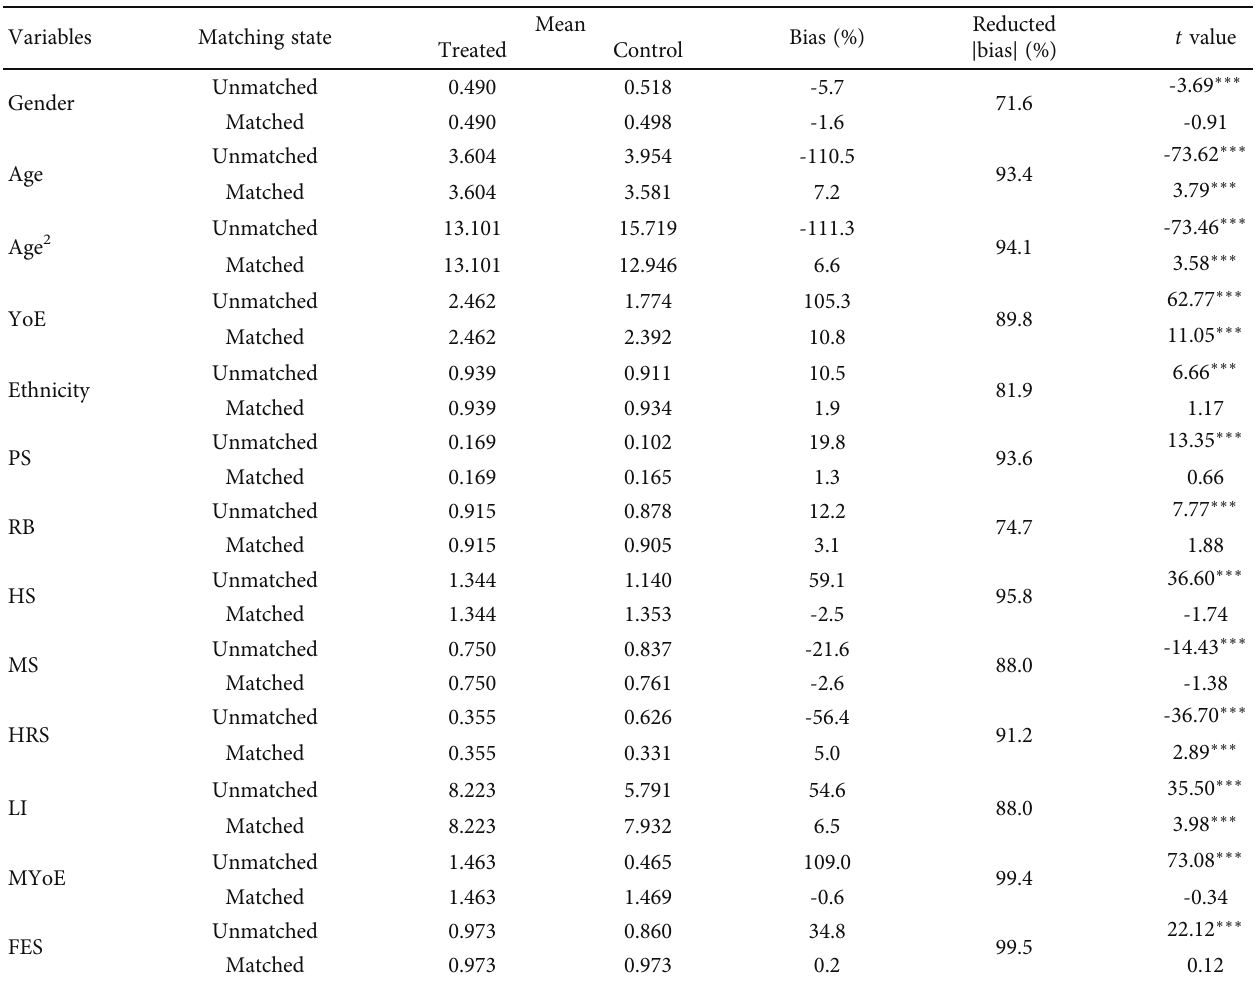
Table 3: Balance test of